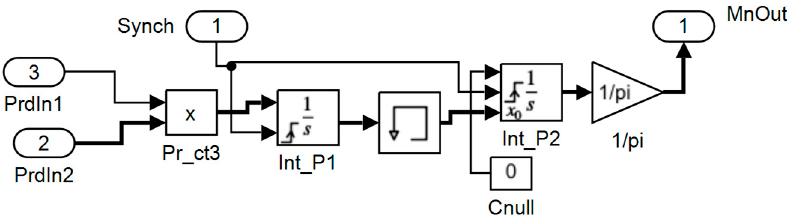
Figure 4. Operational diagram for calculation of sine and cosine components and the square of the rms value of the output of the circuit model.